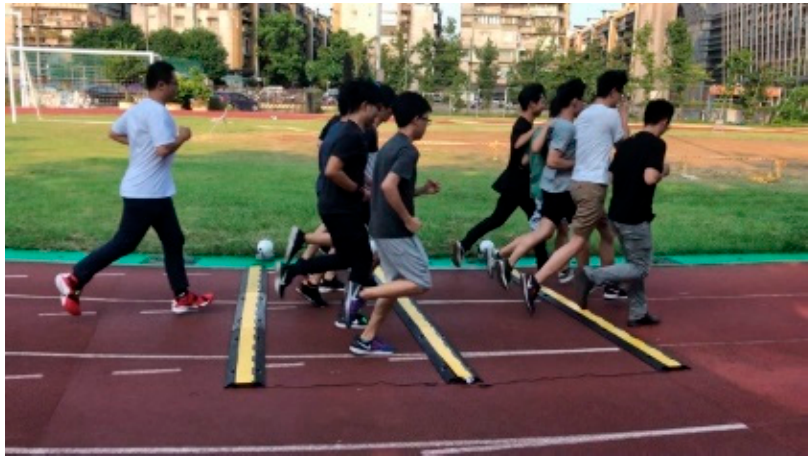
Figure 20. Runners with 20 different BLE Tag configurations, running through three sets of MAT.